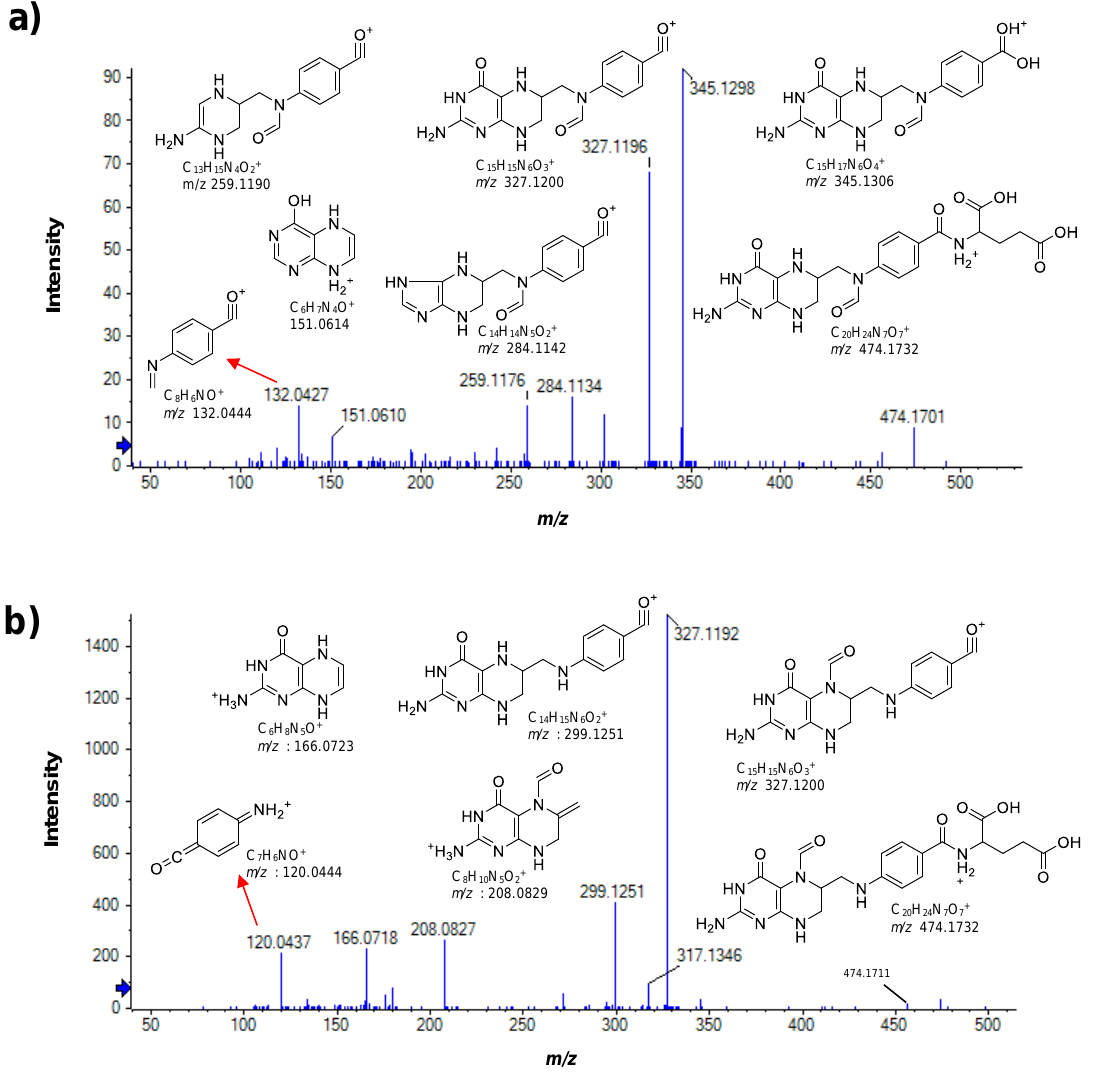
Figure 2. Positive ion mode MS / MS spectra of the two detected formyl-tetrahydrofolate (THF) isomers and the proposed structures of their fragment ions (CE 35 V; CES of 15 V). ( a ) 10-formyl-tetrahydrofolate (10-formyl-THF) and ( b ) 5-formyl-tetrahydrofolate (5-formyl-THF, authentic standard). Peak labels denote accurate masses and fragment ion m / z values denote exact masses.